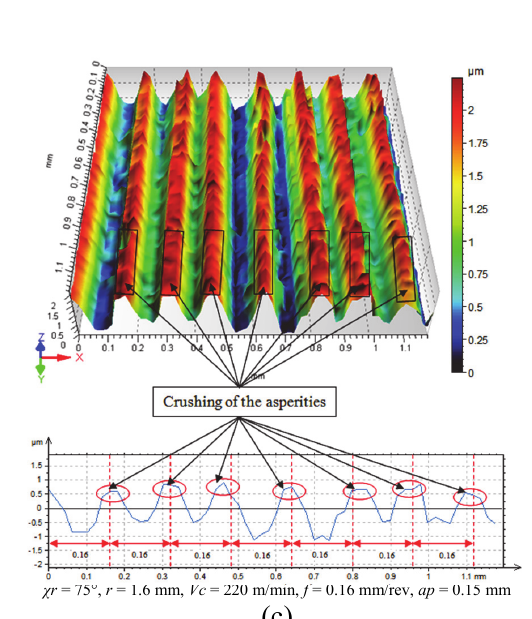
Fig. 7. Example of 2D pro fi le and 3D topography of turned